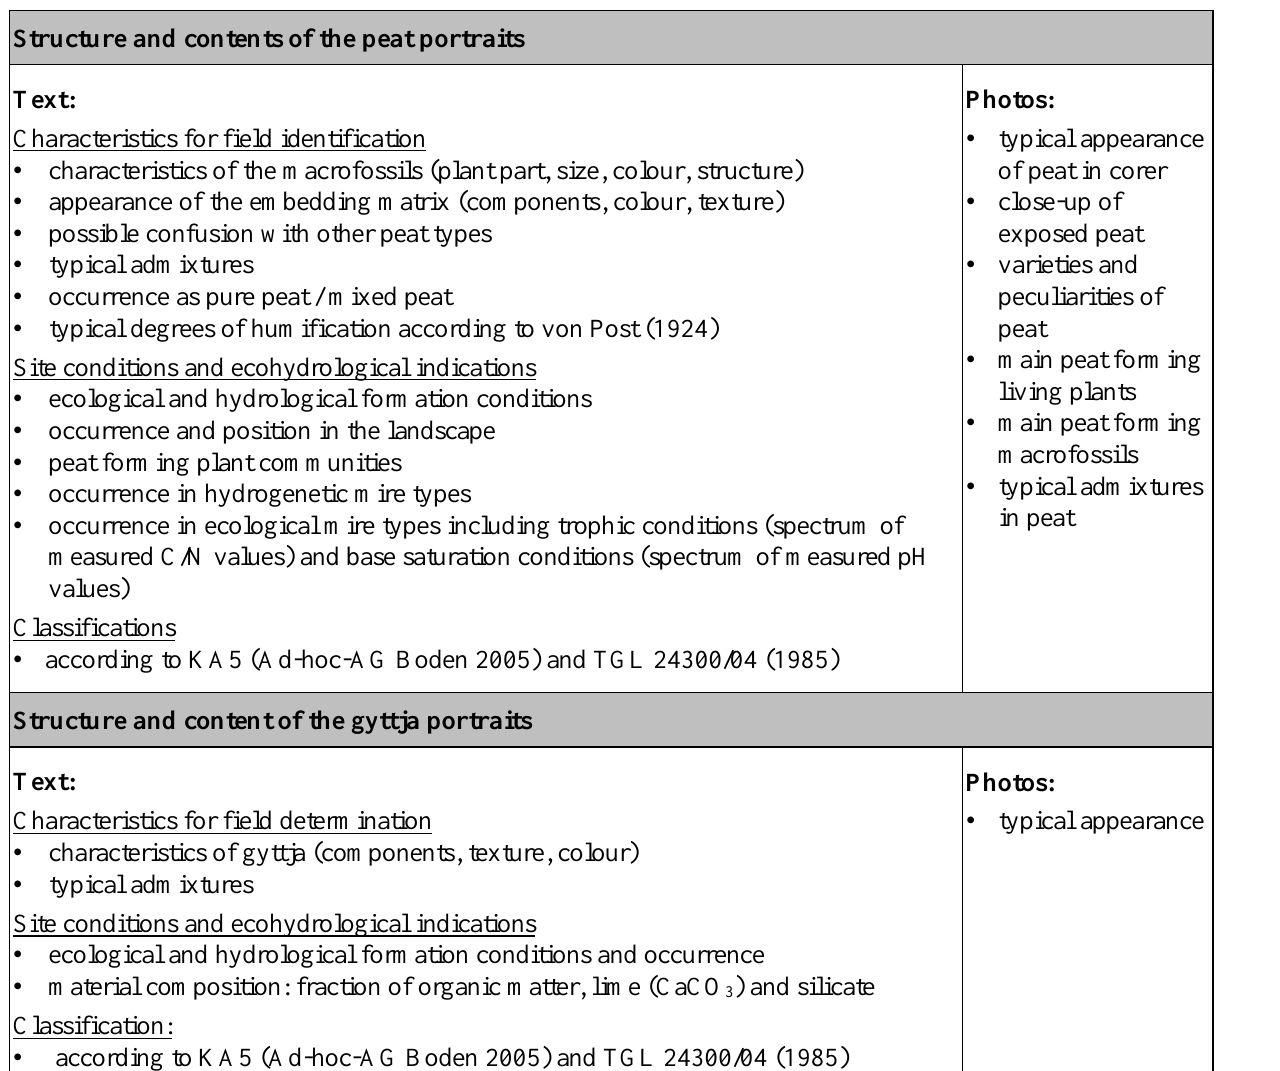
Table 1. Structure and content of the portraits of peatland